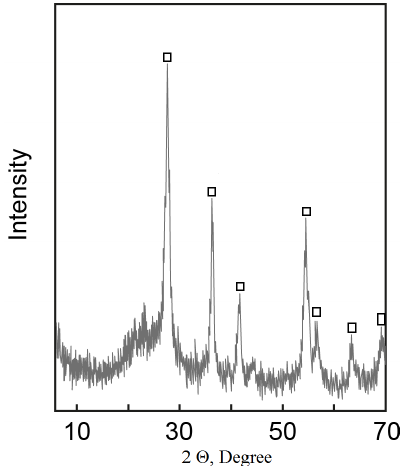
Figure 8. Powder X-Ray diffraction pattern of calcined material (TSK) □ —rutile.